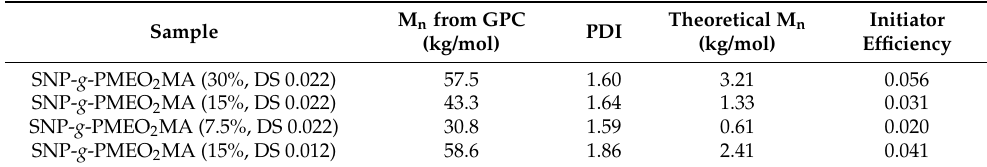
Table 1. Comparison of the number-average molecular weights (M n ) obtained from GPC and NMR